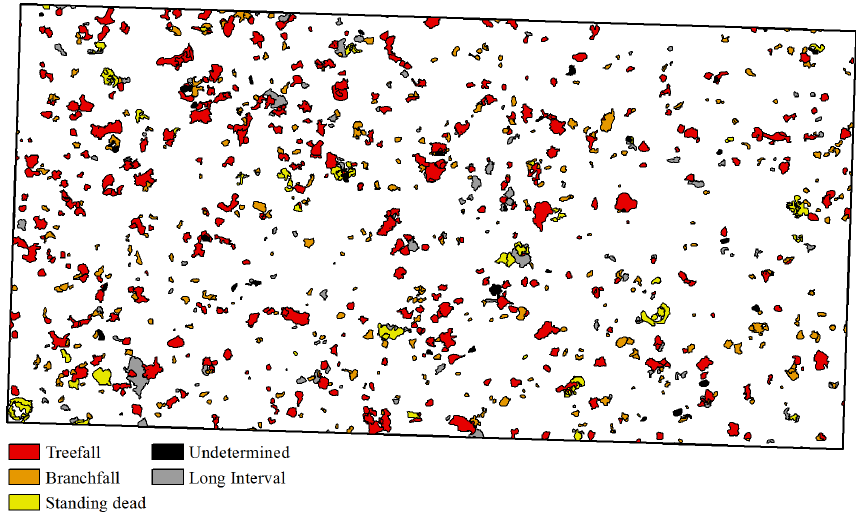
Figure 2. Map of canopy disturbances on the 50ha plot (black rectangle, 1000 × 500m) on Barro Colorado Island, Panama, from 2 Octo- ber 2014 to 28 November